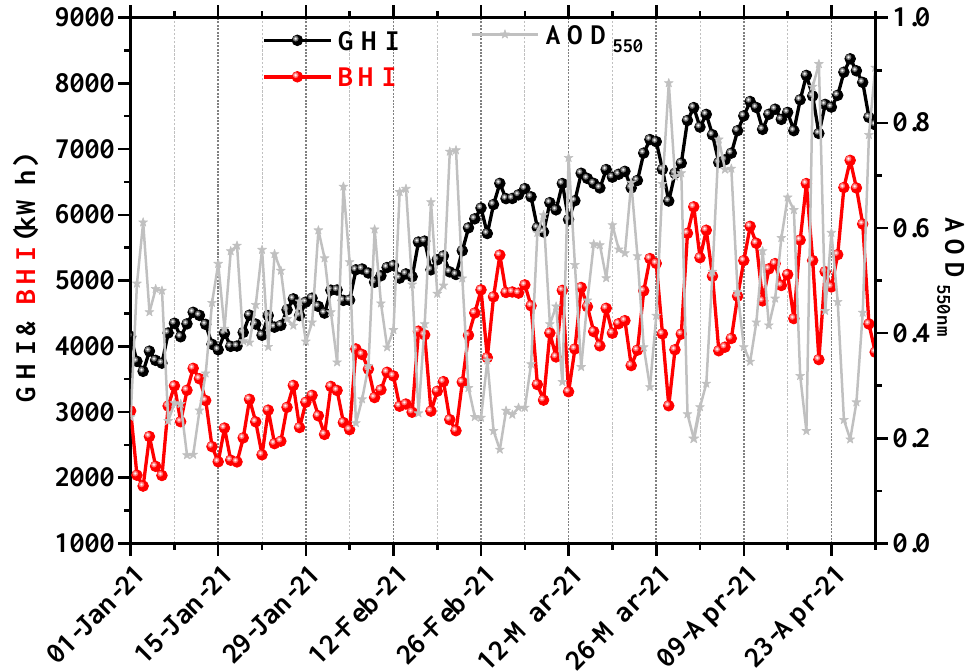
Figure 10. Time-series plots of GHI and BHI on the primary y -axis and AOD 550 nm on the secondary y -axis.